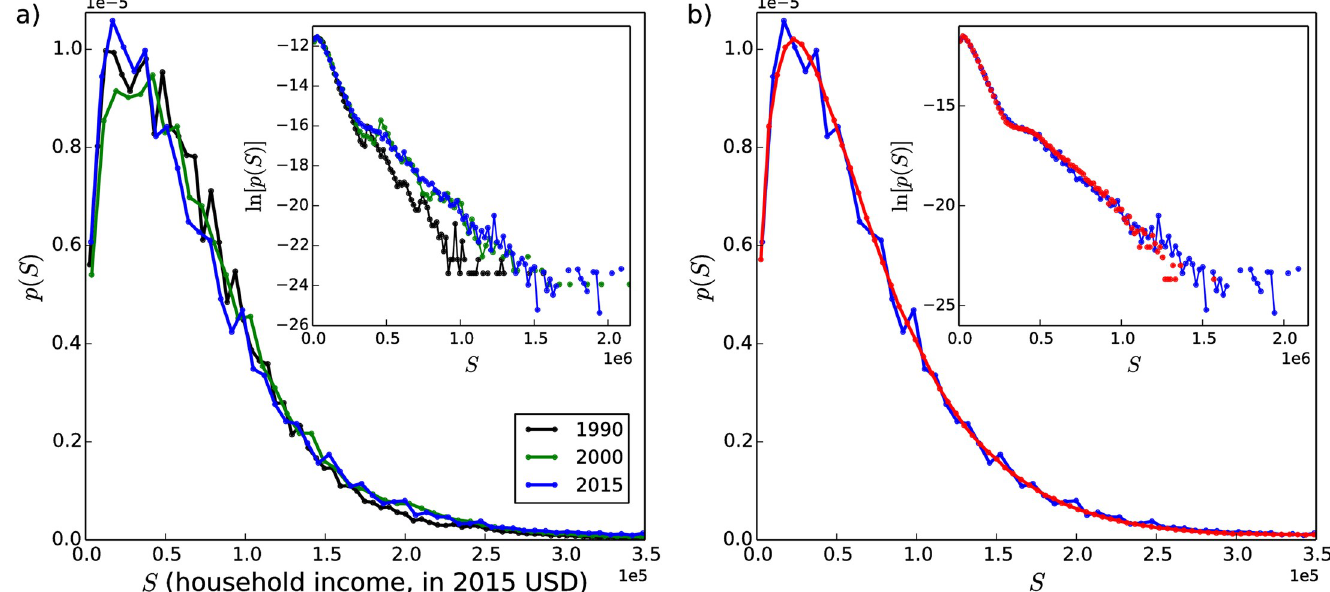
Fig 10. USA household income distributions and fit of extended model. (a) USA household income distributions for three different years (indicated in legend). Dollar values have been converted to 2015 values to allow comparison of the different datasets [75]. A “break” in the data separating the high-income tail from the low- to-middle part of the income distribution can be seen in the inset at S � $250, 000 ( S = 0.25 × 10 6 ). Upper-income cutoffs have been applied to the American data by the governmental agency that provided the data, causing the plateau in ln[ p ( S )] (inset) for the highest income values. (b) Fit of extended model status distribution to USA household income distribution. Simulated distribution (red curve) with parameters δ = 0.4, α = 0, η = 3.5, � = 0.08 compared to the distribution of USA household incomes from the year 2015 (blue curve).